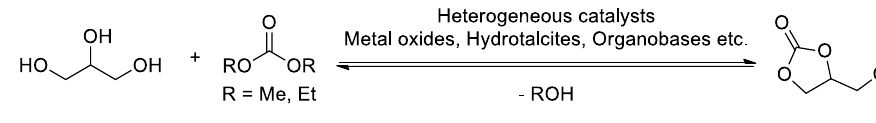
Figure 4. Heterogeneous catalysis in the transesterification of glycerol.